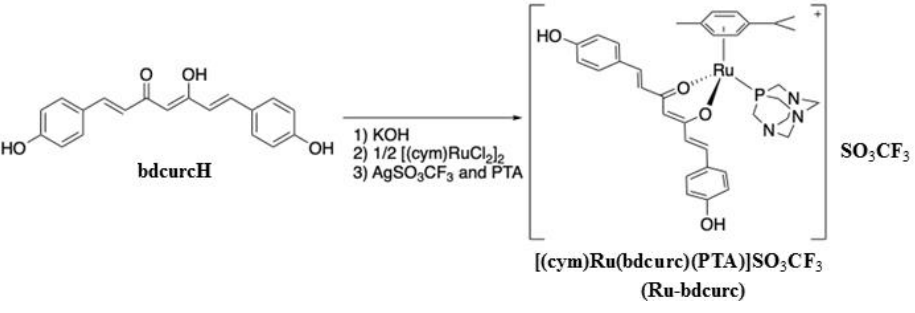
Figure 1. Molecular structure of the compound